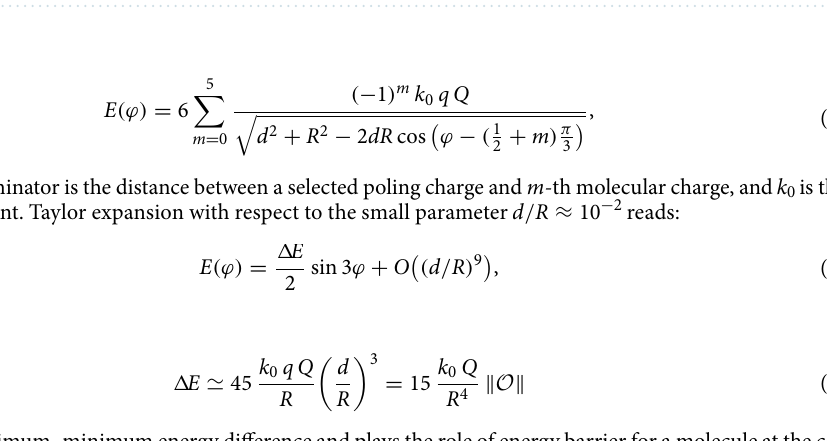
Figure 2. Octupoling setup: the model octupole with orientation angle ϕ at the center of poling